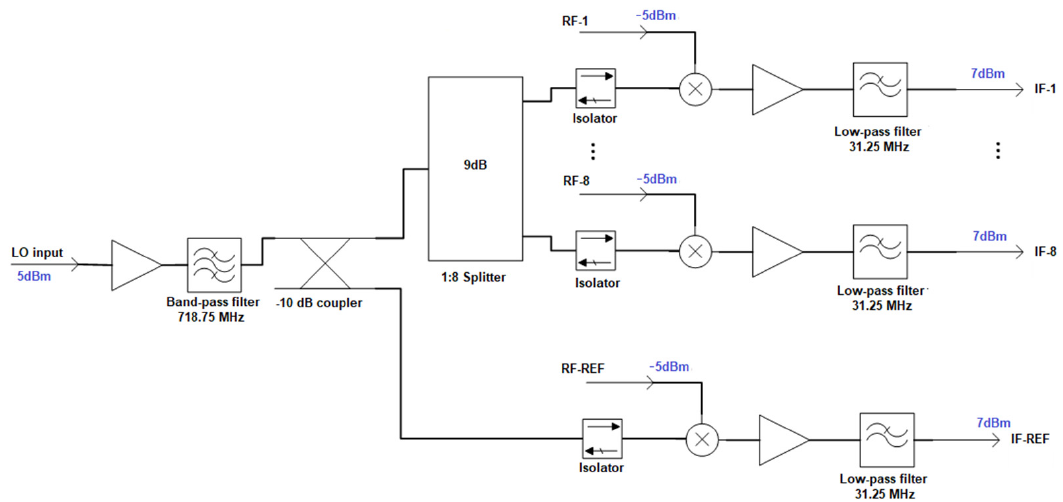
Figure 10. Simplified diagram of the down-mixer block.